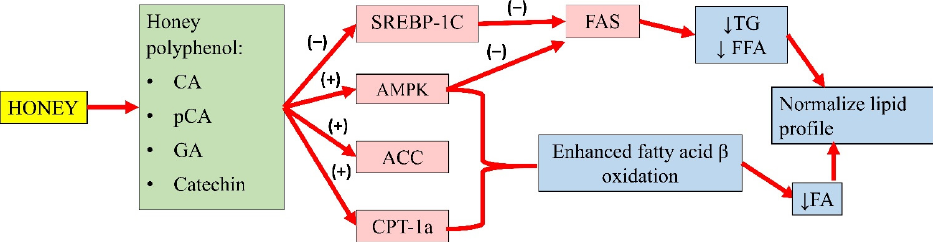
Figure 3. Summary of the antihyperlipidaemic properties of honey. CA, caffeic acid; p-CA, p-coumaric acid; GA, gallic acid; SREBP-1c, sterol regulatory element-binding transcription factor 1c; AMPK, 5 ′ adenosine monophosphate-activated protein kinase; ACC, acetyl-CoA carboxylase; CPT-1a, carnitine palmitoyltransferase-1a; FAS, fatty acid synthase; TG, serum triglyceride; FFA, free fatty acid; FA, fatty acid; ( − ), inhibit; (+), increase; ↓ , reduce.